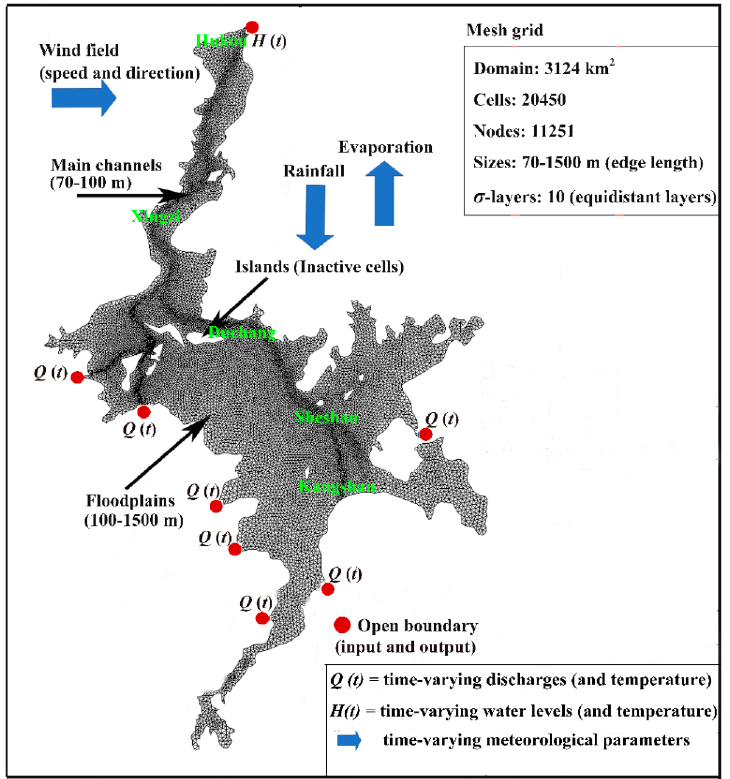
Figure 2. Domain, mesh grid, and major inputs / outputs for the MIKE 21 floodplain model of Poyang Lake, according to Li et al. [45].